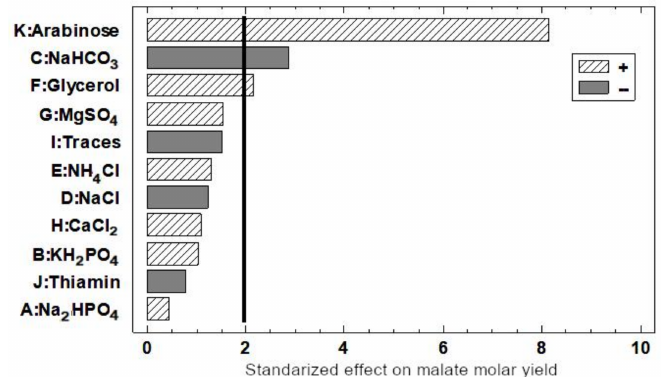
Figure 3. Pareto bar chart of medium culture components screening using malate yield (mol malate per mol glycerol consumed) at 48 h as a response variable. The bars of components that have a negative effect on malate yield are grey and those of components that have a positive effect on malate yield are filled in with diagonal lines. The vertical black line represents the statistically significant value with a 95% confidence